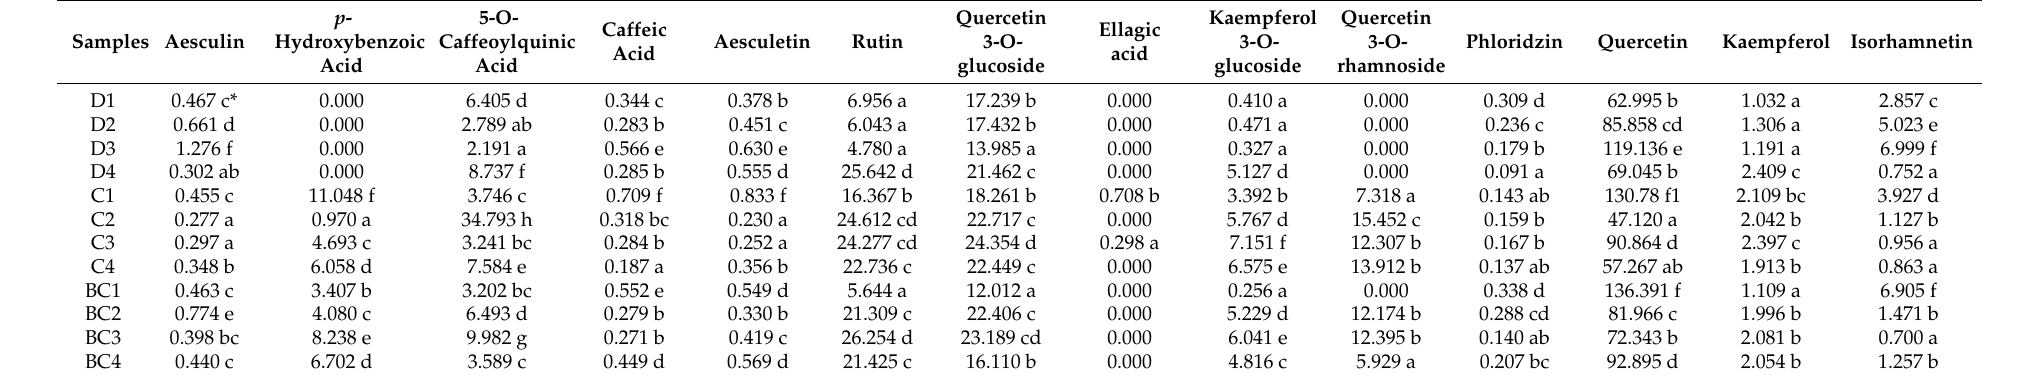
Table 6. Phenolic content found in blueberries (mg/kg frozen